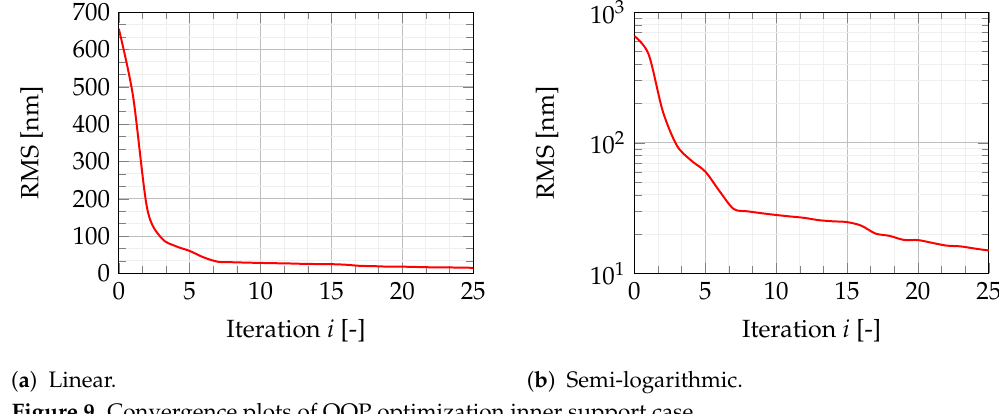
Figure 9. Convergence plots of OOP optimization inner support